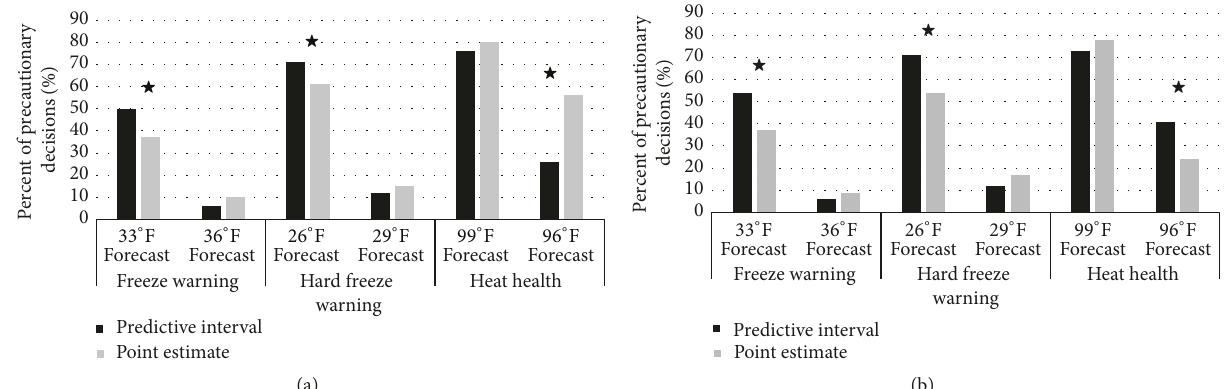
Figure 3: The percentage of participants who took precautionary action in point estimate and predictive interval conditions over forecasts in Experiment 1 (a) and Experiment 2 (b). The threshold temperature was inside the predictive interval for the 33 ∘ F (0.6 ∘ C), 26 ∘ F ( − 3.3 ∘ C), and 99 ∘ F (37.2 ∘ C) forecasts. Stars indicate statistically significant